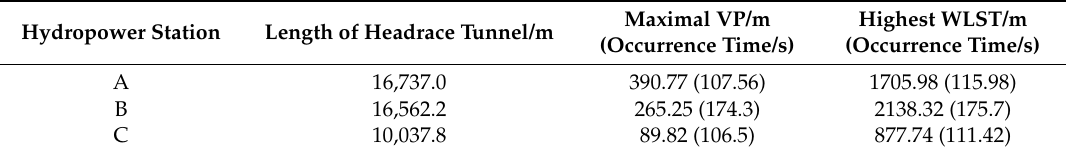
Table 2. Length of headrace tunnel, the maximal VP, and highest WLST of hydropower stations A, B, and C during load rejection [52].